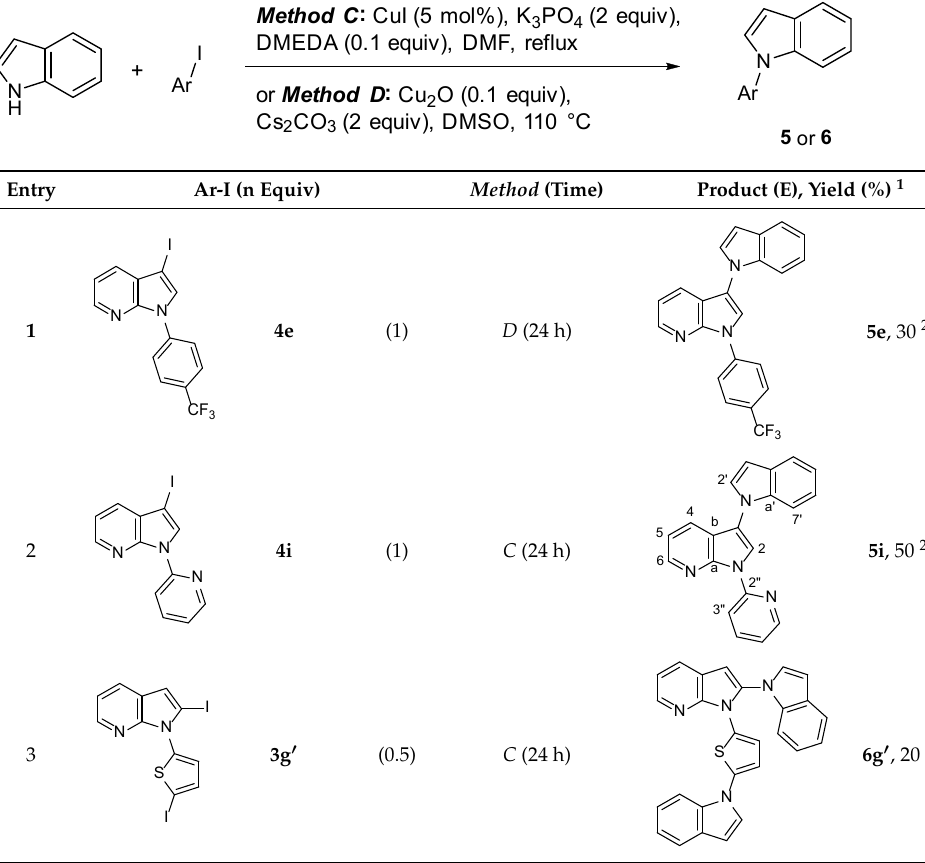
Table 4. N -arylation of indole by a few of the prepared iodides.